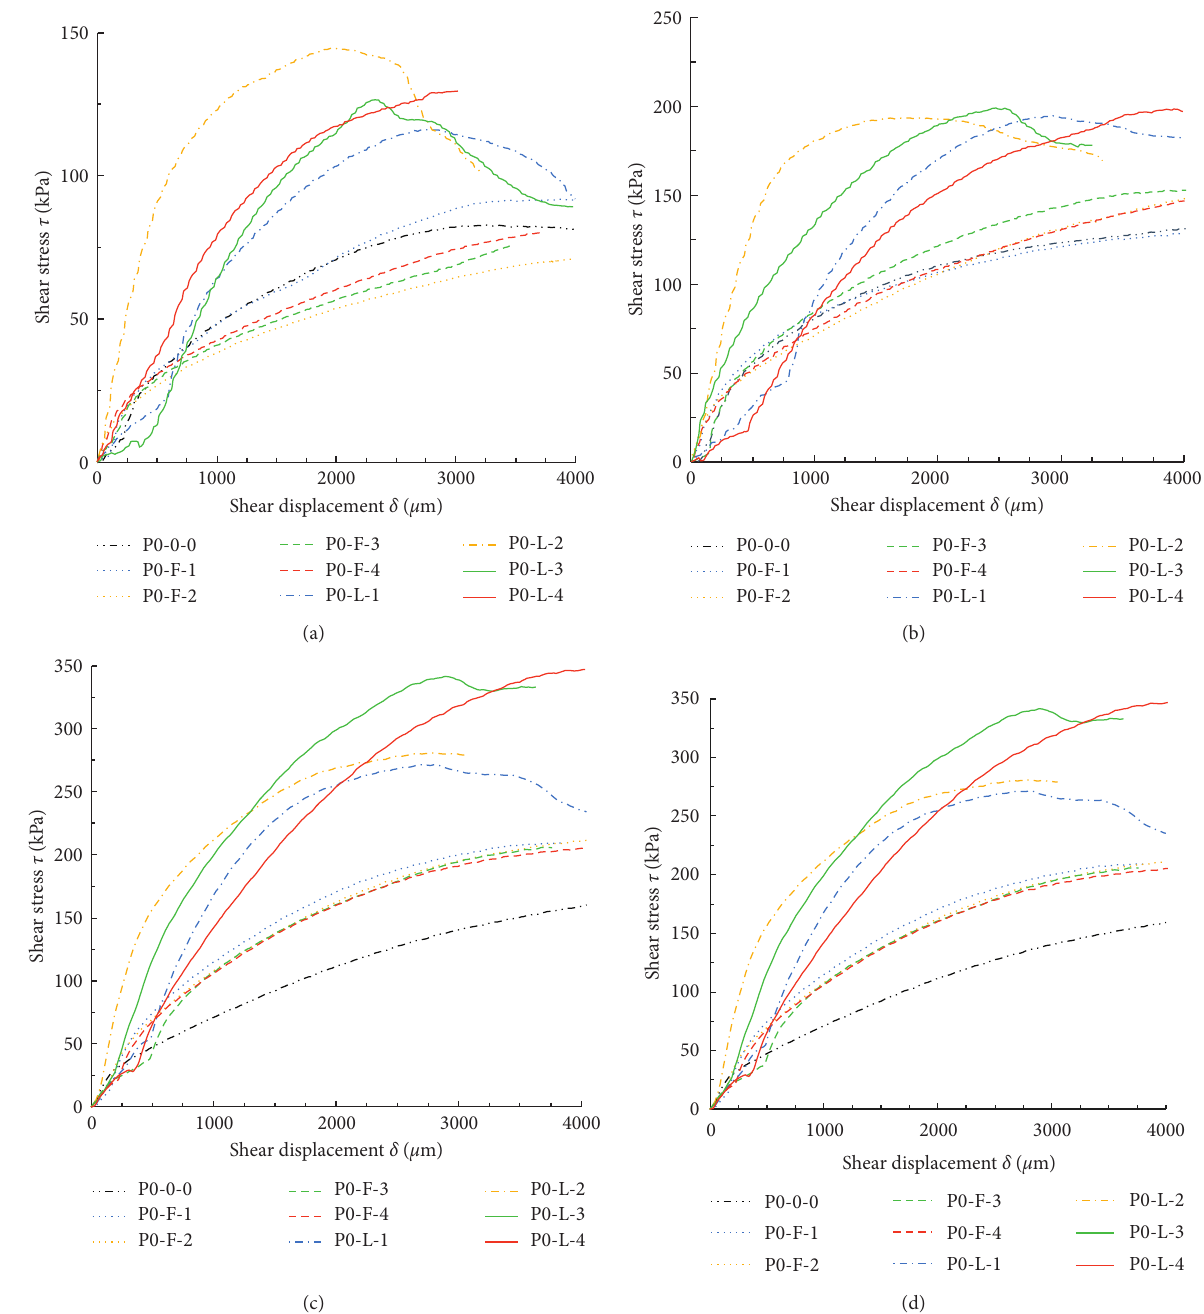
Figure 1: τδ curves of the modified iron tailings with the 0 freeze-thaw cycle: (a) 100kPa normal stress, (b) 200kPa normal stress, (c) 300kPa normal stress, and (d) 400kPa normal